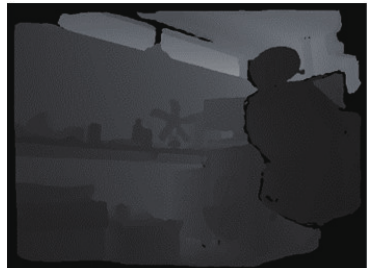
Figure 13. Anisotropic equation repair depth image.